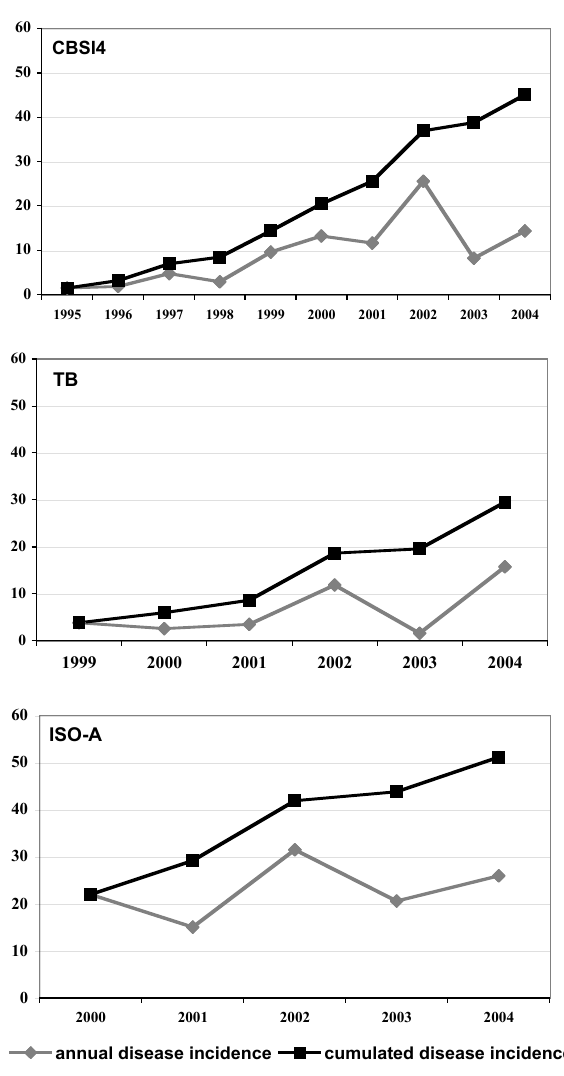
Fig. 2. Annual incidence of manifest esca ( ◆ ) and cumu- lated esca ( ■ ) in three vineyards at Siena (CBSI4), Ra- venna (TB) and Florence (ISO-A).